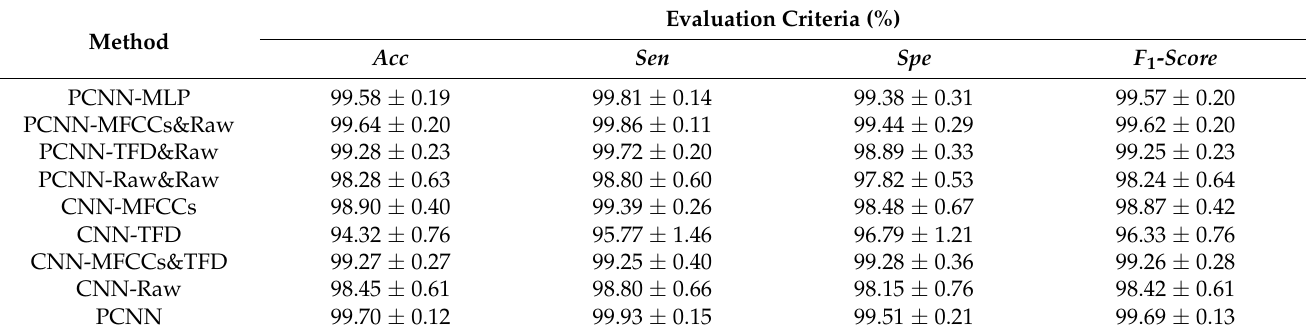
Table 8. Quantitative comparison among different